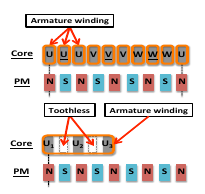
Figure 1: Ordinary 8-pole 9-stator-core combination.